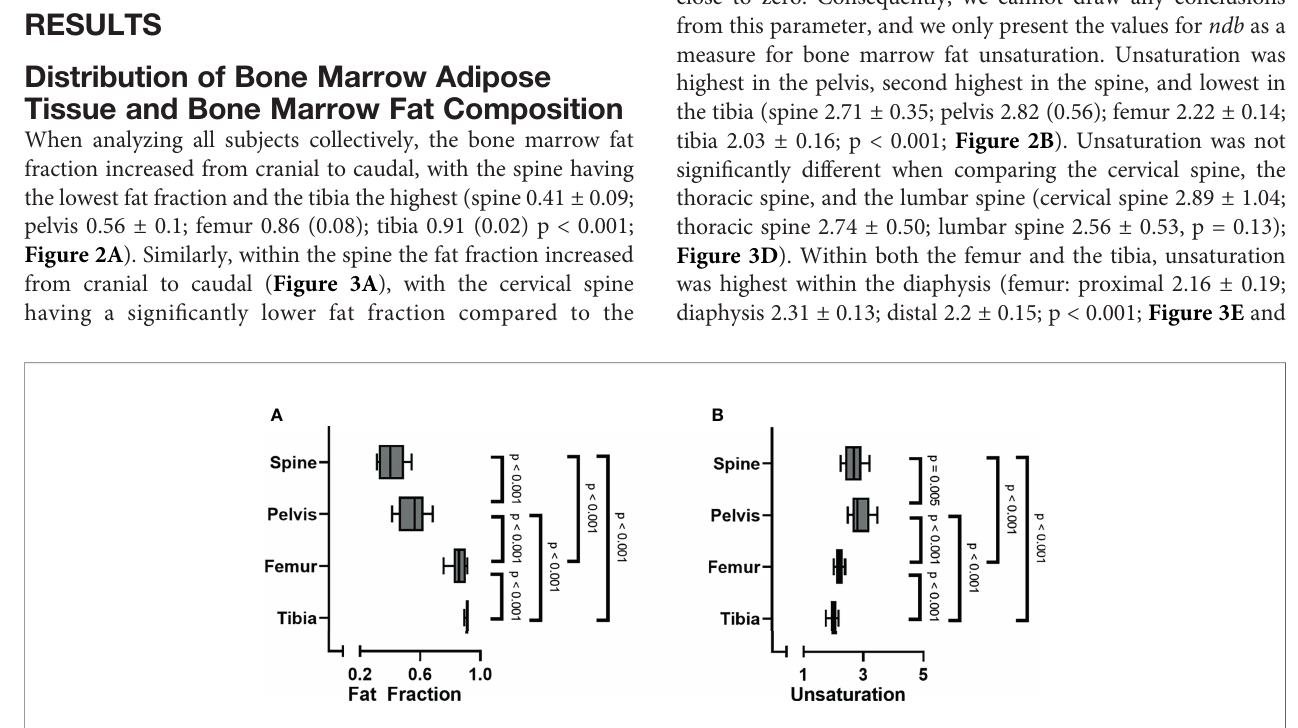
FIGURE 2 | (A) Bone marrow fat fraction increased from cranial to caudal (linear mixed model (LMM): p < 0.001). (B) Unsaturation (number of double bonds, ndb ) was highest within the pelvis, followed by the spine, and lowest within the tibia (LMM: p <